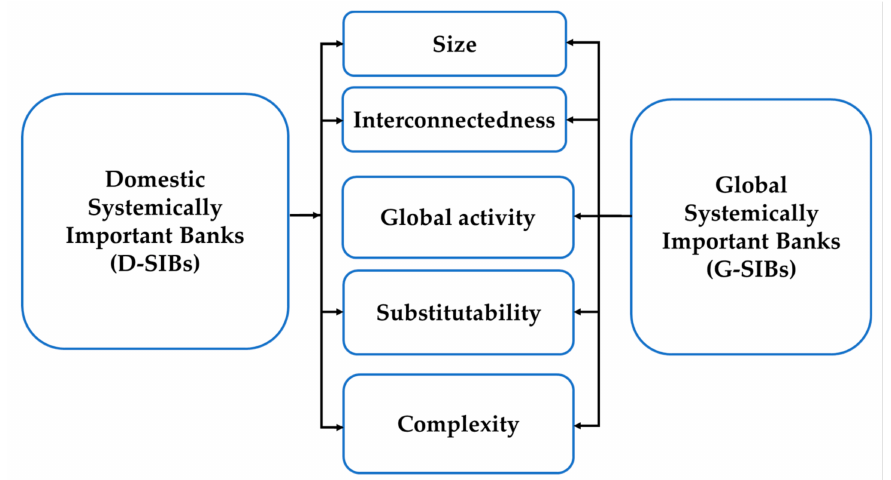
Figure 1. The indicator